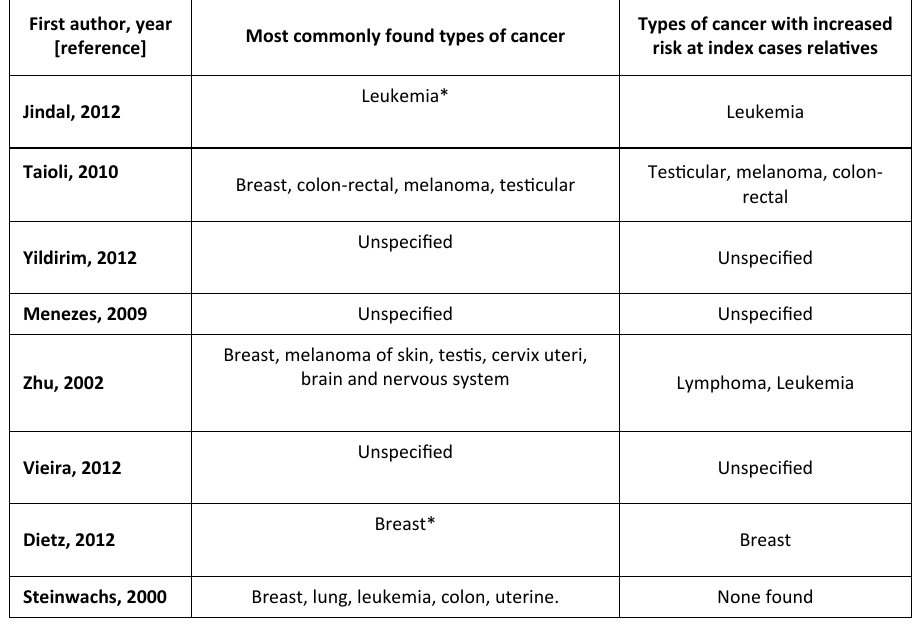
*The study speci fi cally searched for this type of cancer only.